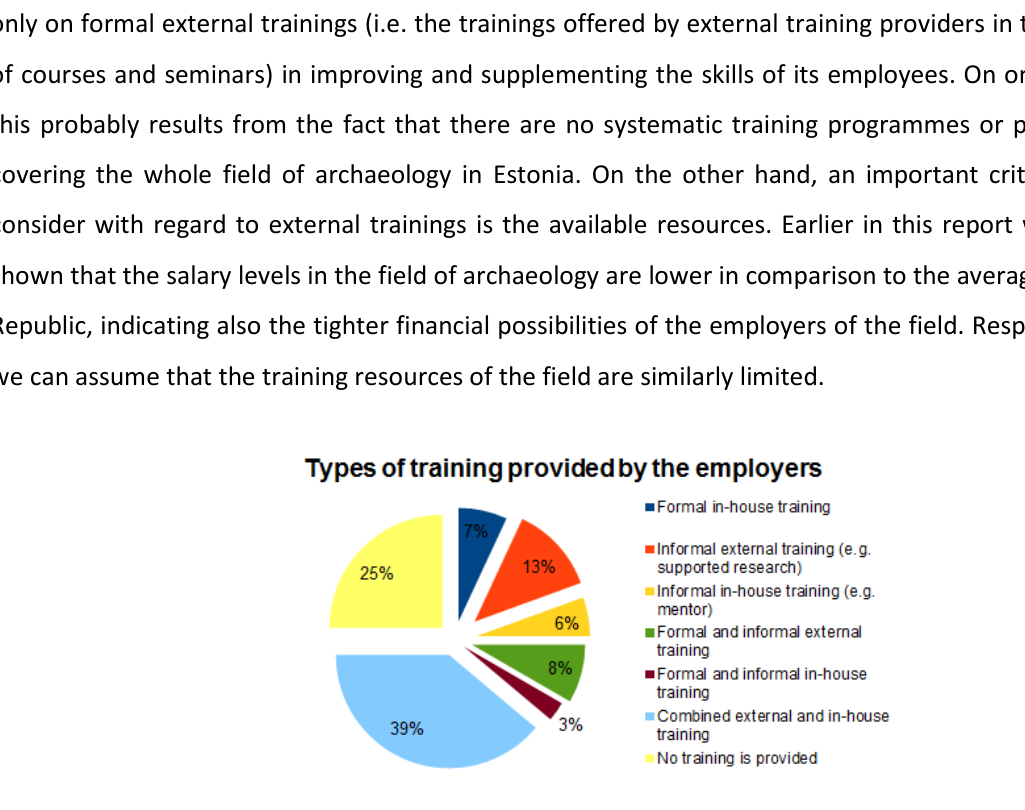
Figure 17 - Types of supplementary